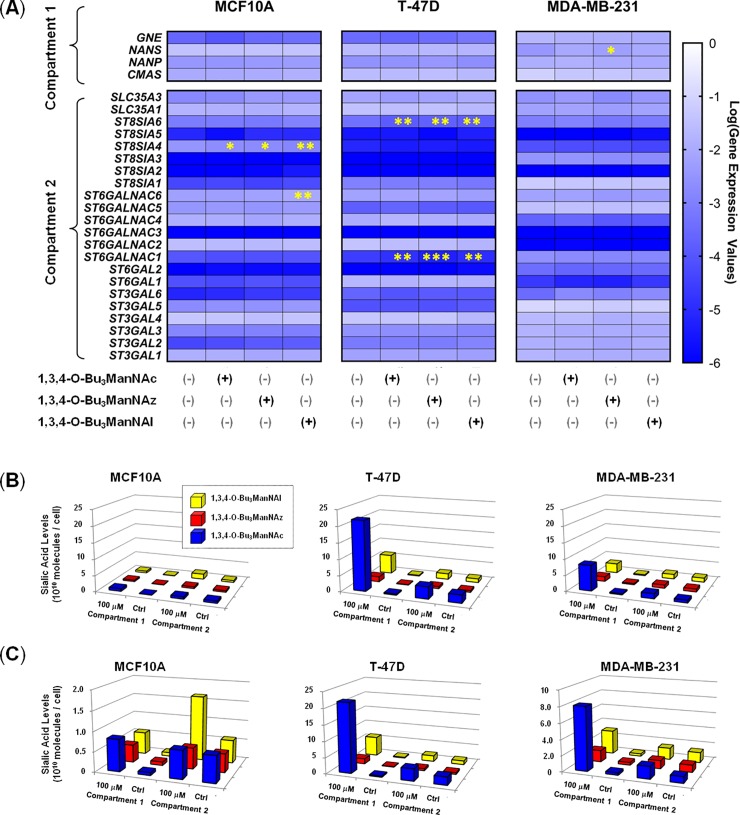
Transcript levels of SAMG genes and correlated sialic acid levels in ManNAc analog-treated cells.(A) Heat maps of SAMG genes associated with Compartment 1 and Compartment 2 in each of the breast cell lines upon analog treatment as indicated. (B) Compartment 1 and 2 levels of sialic acid in analog-treated cells (100 mM for 24 h) with the same data plotted in (C) with an expanded y-axis for the MCF10A and MDA-MB-231 lines. Although not readily apparent in the heat map color scheme, several minor but statistically-significant differences in transcript levels were observed as indicated by the asterisks (* p < 0.05, ** p < 0.01, *** p < 0.001 based on the statistical analysis presented in the supporting data (Columns D-F in
S2 File).